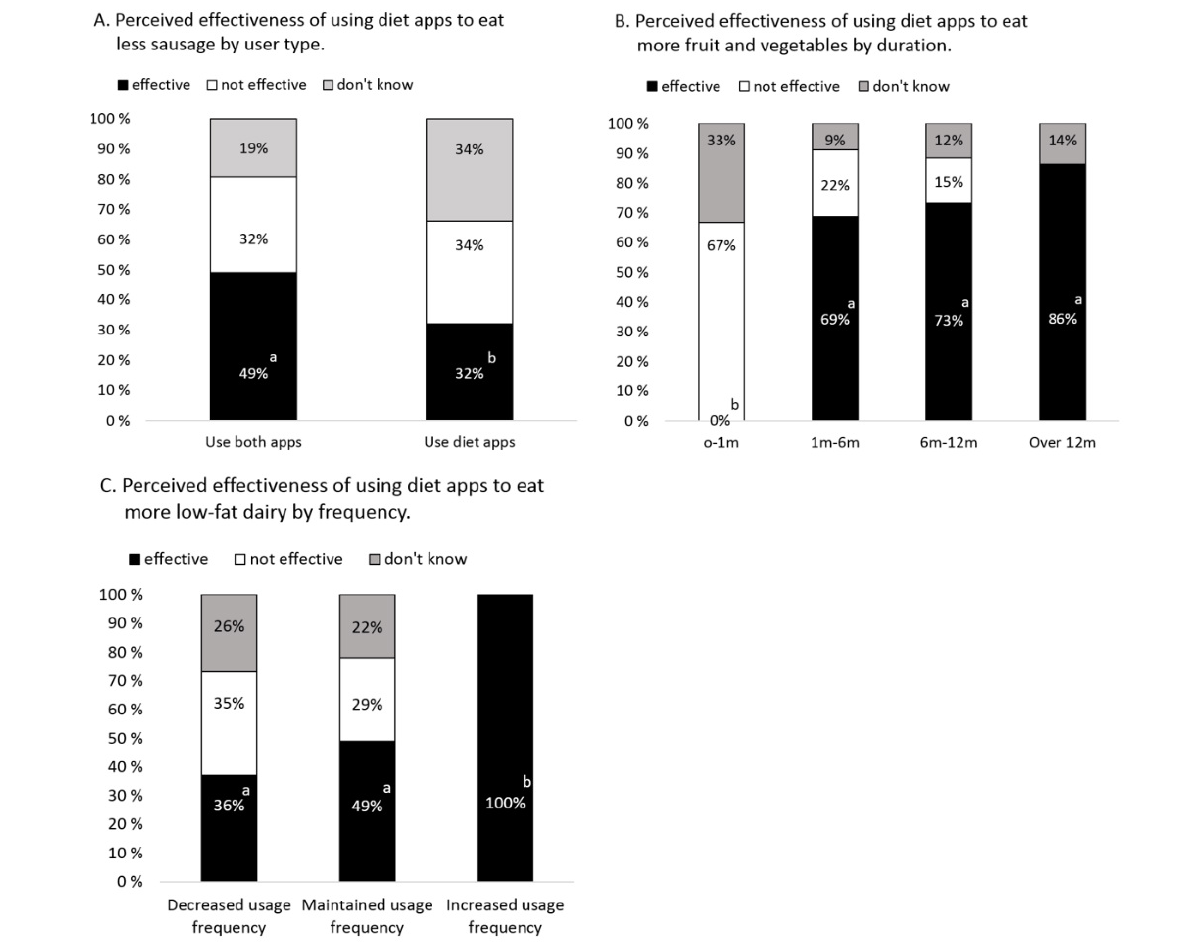
Figure 2. Percentages of different diet app user categories and their evaluation of the effectiveness of using diet apps to assist their food